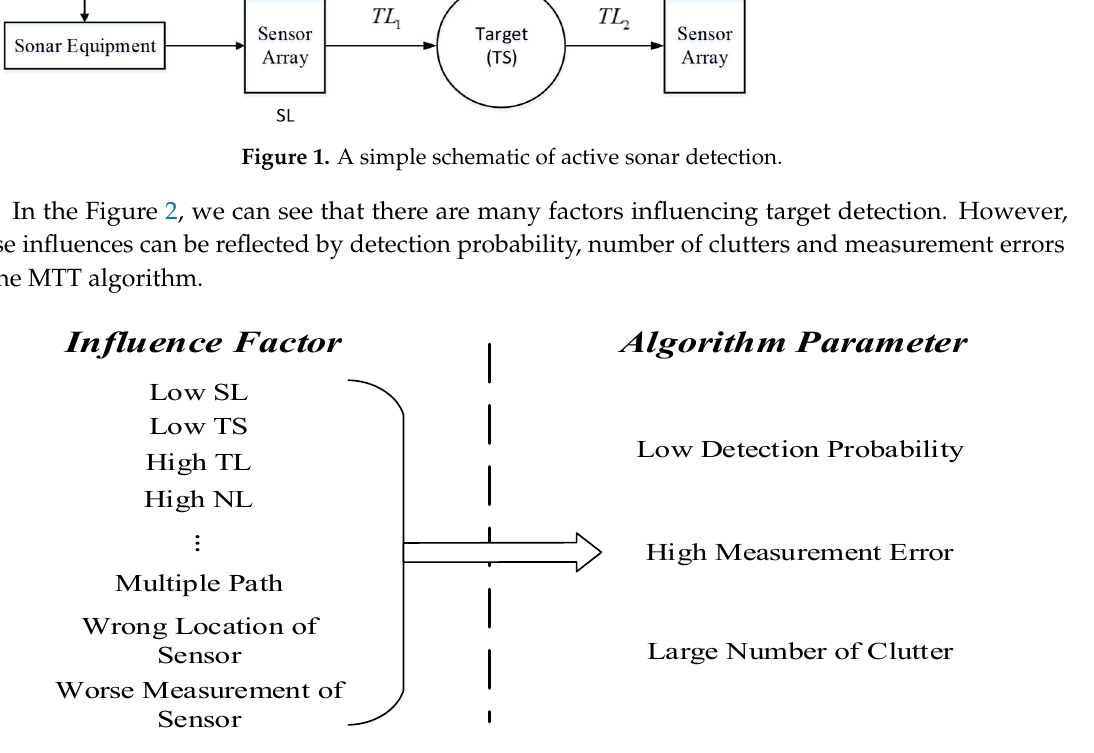
Figure 2. The relationship between influence factors and algorithm parameters.